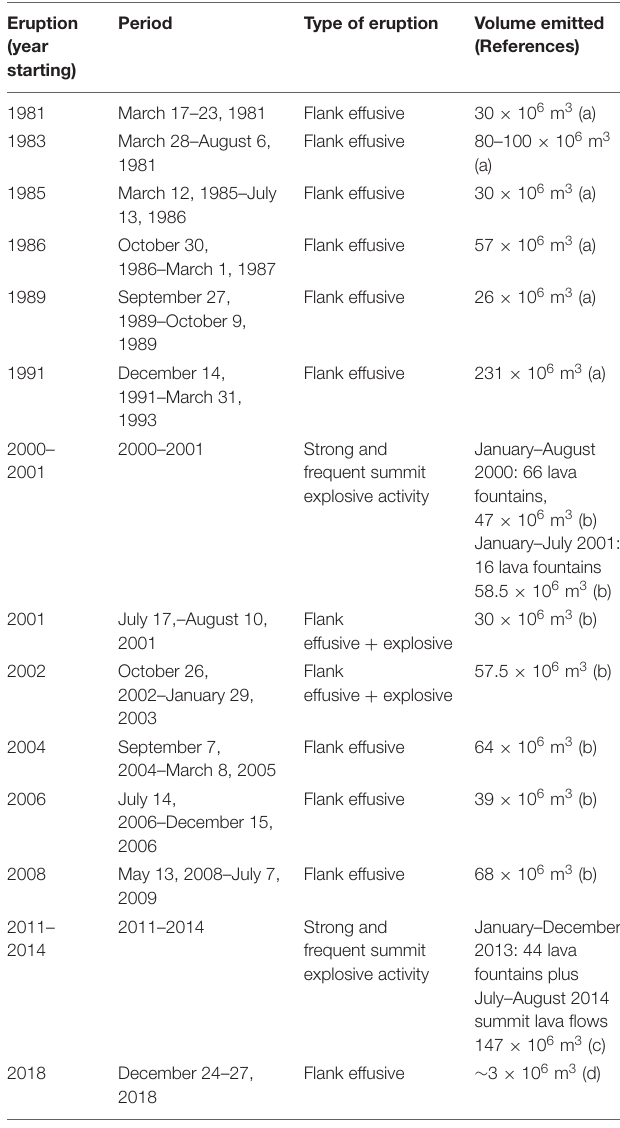
TABLE 1 | Main flank eruptions and prolonged strong explosive periods from 1981 to 2018 emitting large lava